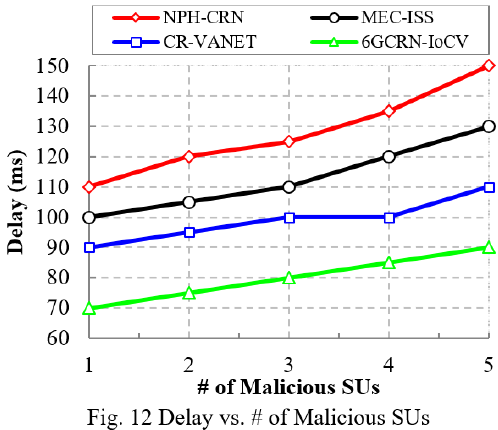
Figure 12. Delay vs. the number of malicious SUs.